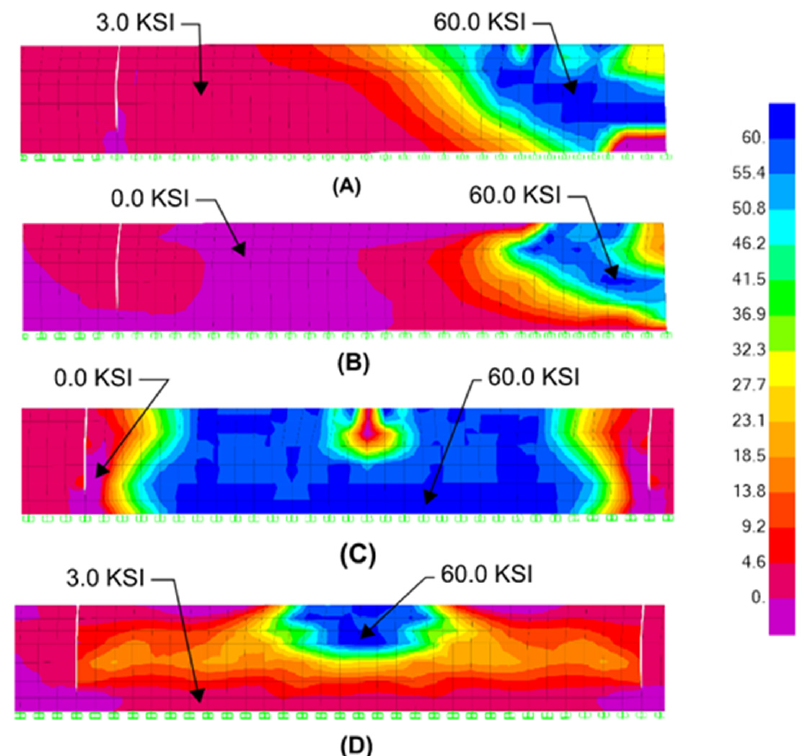
Figure 6. The parapet stress pattern (ksi) for ( A ) End Segment Vertical Reinforcement, ( B ) End Seg- ment Longitudinal Reinforcement, ( C ) Interior Segment Vertical Reinforcement, and ( D ) Interior Segment Longitudinal Reinforcement.